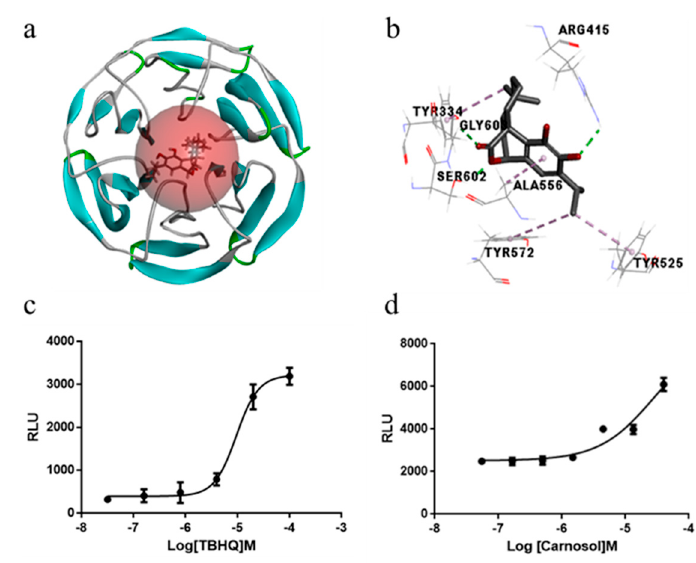
Figure 6. Docking mode of carnosol in the binding site of Keap1 and ARE-mediated luciferase activity. ( a ) Top view of the docking mode of carnosol in the binding site of Keap1. ( b ) The potential interaction between carnosol and Keap1 is via hydrogen bonds and hydrophobic. Potential hydrogen bonds were depicted in green dot lines and hydrophobic were depicted in purple dot lines. ( c ) Dose-response curves of ARE agonist (t-BHP) served as a positive control in this study. ( d ) Carnosol induced ARE-luciferase activity in a dose-dependent manner. Results are expressed as mean ± SD ( n = 3).